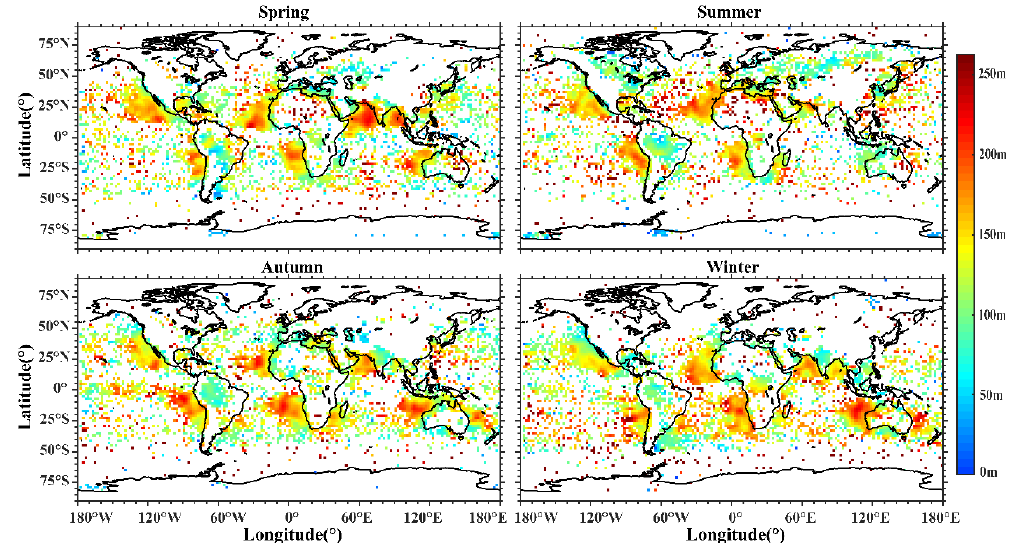
Figure 11. Distribution of the trapping layer thickness with season variations. The blank grids represent that there is no trapping layer event.